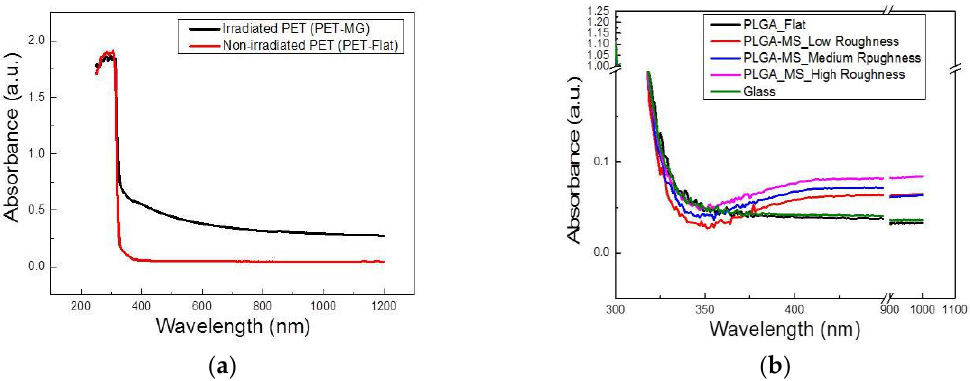
Figure 4. ( a ) UV–Vis measurements of irradiated PET (PET-MG) and non-irradiated PET (PET-Flat); ( b ) UV–Vis measurements of all the PLGA-MS replicas, as well as the PLGA flat and glass substrates.